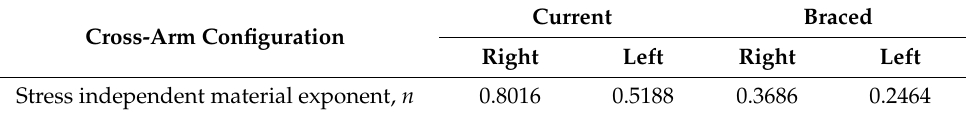
Table 3. Stress independent material exponent, n of both current and braced wooden cross-arms. Current Braced Cross-Arm Configuration Right Left Right Left Stress independent material exponent,